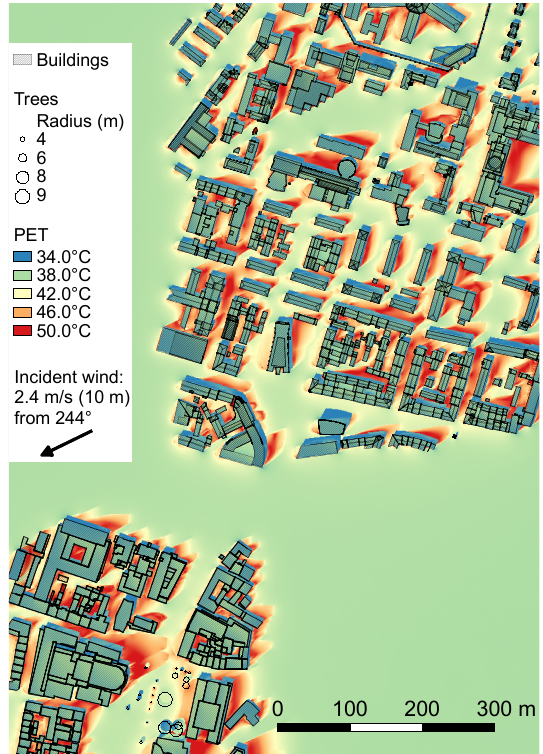
Figure 3. Physiologically Equivalent Temperature (PET) on 1 July 2008 at 1:30 p.m. in a height of 1.1 m above ground level. The calculations consider both the "Institutes Quarter" ( upper right ) and the "Place of the Old Synagogue" ( lower left ) together in one large area of